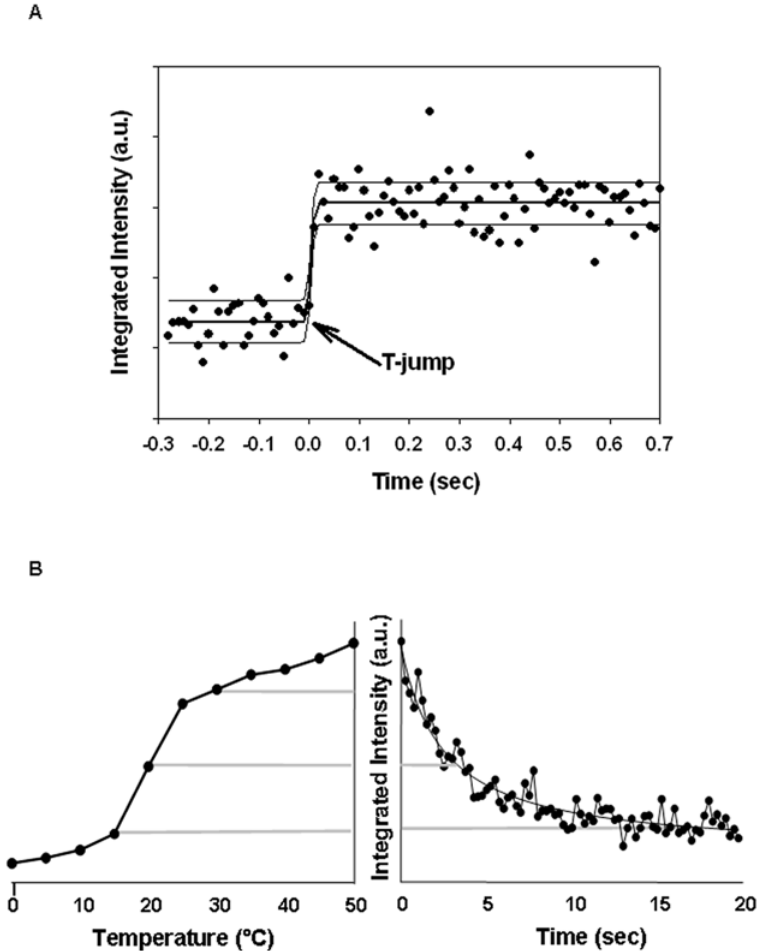
Figure 3. Time-resolved nanophase transition in LDL. The rise in the integrated intensity of the 1st side-maximum upon laser jump is shown as a function of time (A). The time slicing was 10 ms per image. The time point of laser flash is set to zero seconds. The error function of statistical variation displays a maximum inaccuracy in time of about 5 ms. Thus, the offset in transition is much shorter than the sampling time of 10 ms and the 2 ms of laser flash. The integrated intensities of the 1st side-maximum obtained by static measurements within a temperature range of 0 u C and 50 u C with a step width of 5 u C (B, left panel) are correlated to the time-course of integrated intensities of the 1st side-maximum obtained by dynamic measurements (B, right panel). For static measurements, a measuring time of 30 s and an equilibration time of 10 minutes at each temperature was chosen. For dynamic measurements, the measuring time per frame was 250 ms. A half-time of 2 seconds, corresponding to a temperature drop of about 10 u C, could be achieved to pass through the transition temperature. The decline in integrated intensity strictly followed the drop in temperature. Tm for the LDL sample shown was about 22 u C, as determined by microcalorimetry.